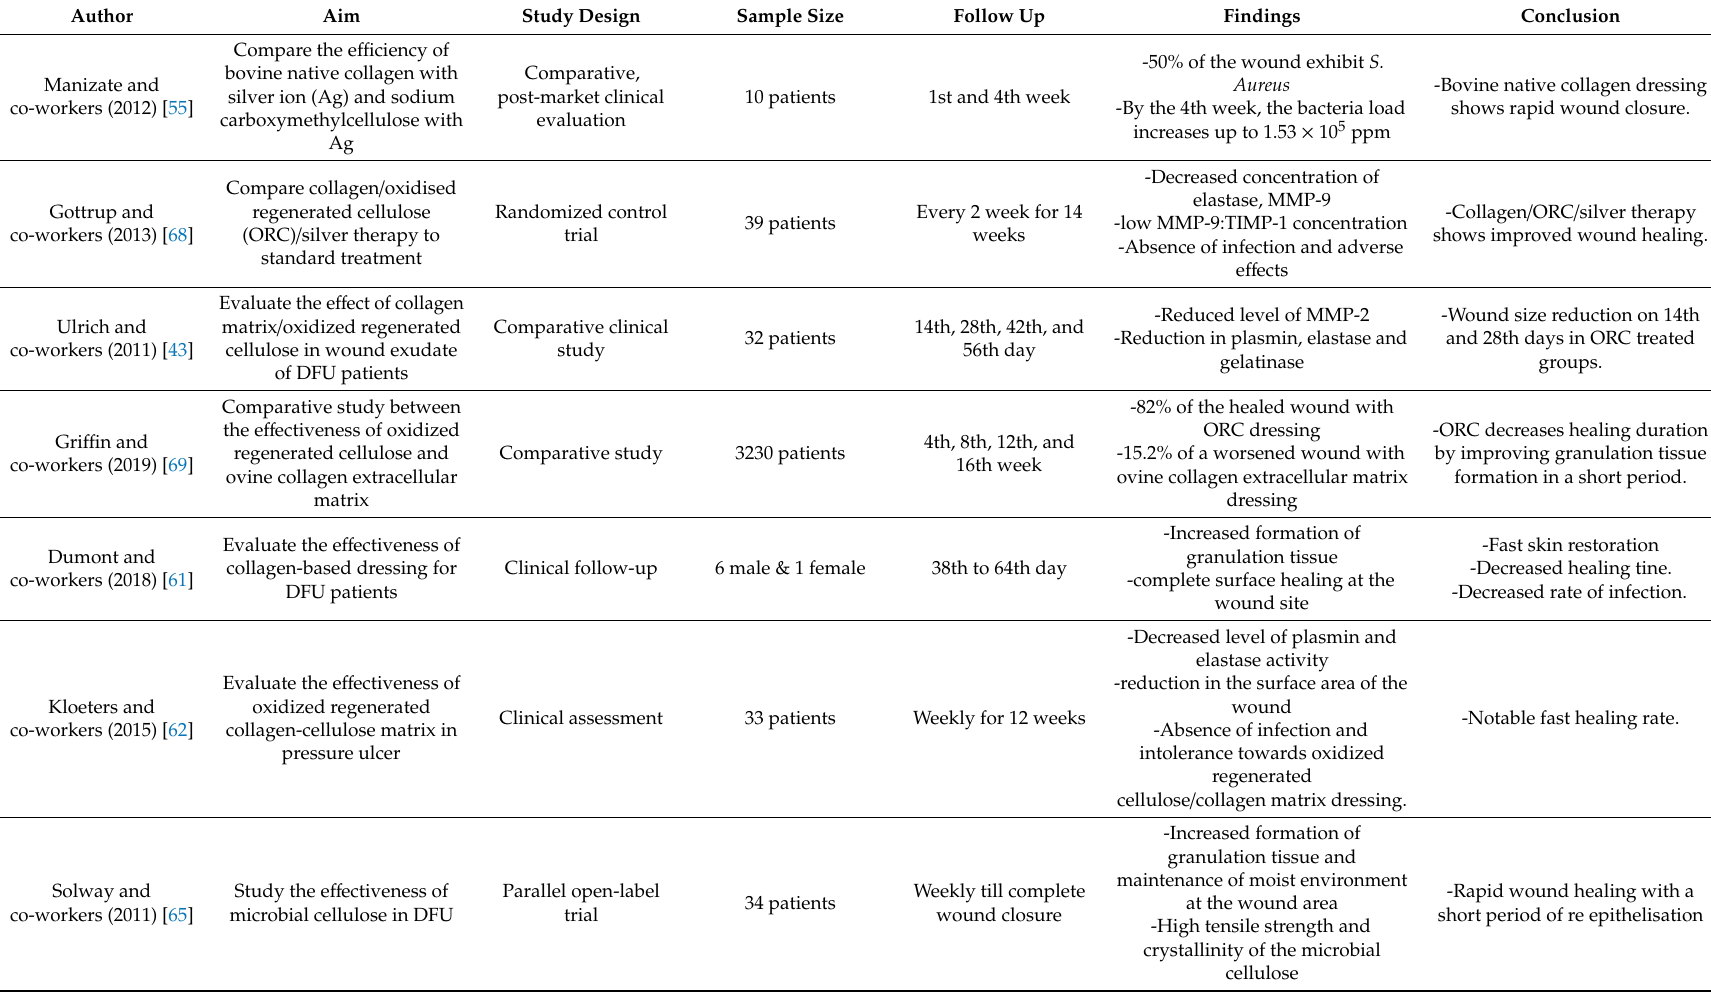
Table 1. Cellulose / collagen dressing for